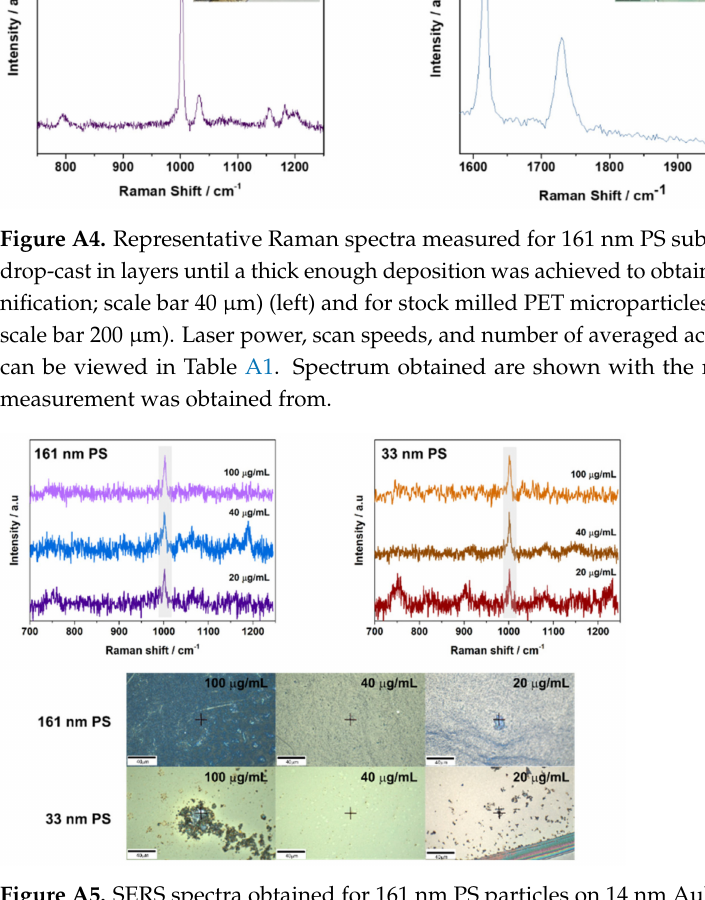
Figure A5. SERS spectra obtained for 161 nm PS particles on 14 nm AuNP substrates as well as the 33 nm PS nanoparticles on 14 nm AuNP substrates. Spectrum obtained are shown above images of the region of interest (ROI) the measurement was obtained from. Scale for all is 40 µ m. Laser power, scan speeds, and number of averaged accumulations for the samples can be viewed in Table A1.